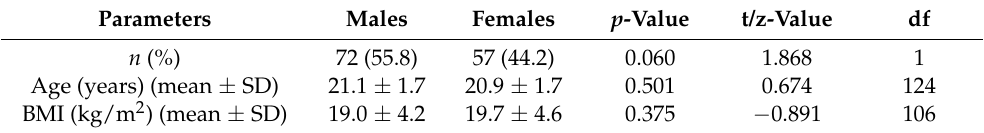
Table 1. Demographic and anthropometric information of participants ( n = 129). Parameters